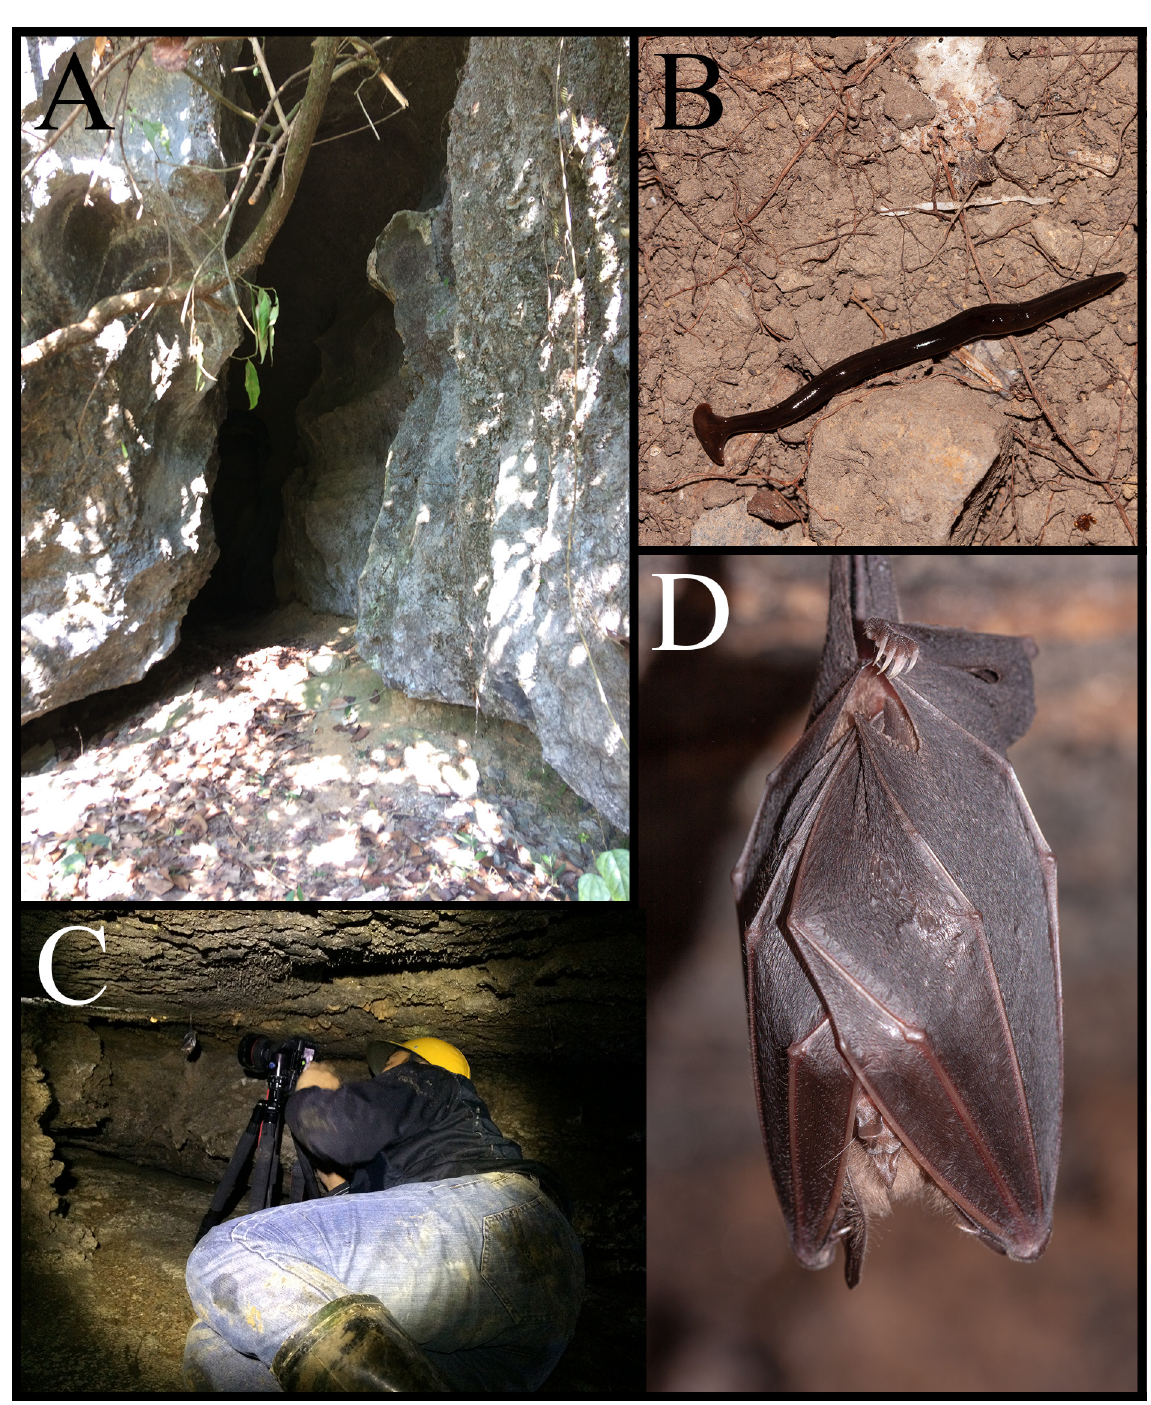
Fig. 6. Dapo Dong cave, type locality of Guiodytes weii Huang & Faille sp. nov. A . Entrance. B . A flatworm (Turbellaria) in the cave. C . Guofu Wei taking pictures in the Dapo Dong cave. D . A bat observed in the